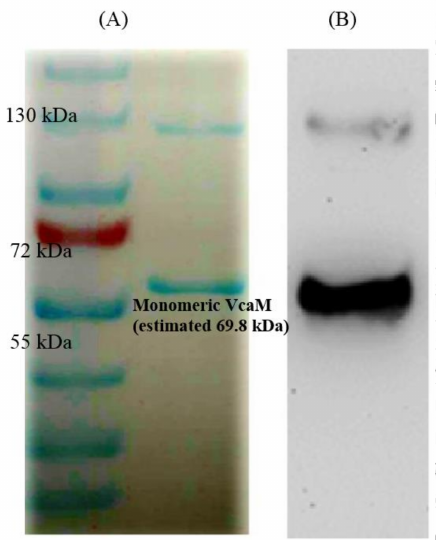
Figure 1. The ( A ) Sodium dodecyl sulfate-polyacrylamide gel electrophoresis (SDS-PAGE) and ( B ) Western blot of V. cholerae VcaM. The 10% SDS-PAGE showed the purified fraction of monomeric VcaM (right lane, between 55 and 72 kDa) and dimeric VcaM (right lane, slightly below 130 kDa). The Western blot was performed with a mouse anti-histidine tag primary antibody and goat anti-mouse IgG-AP conjugate as the second